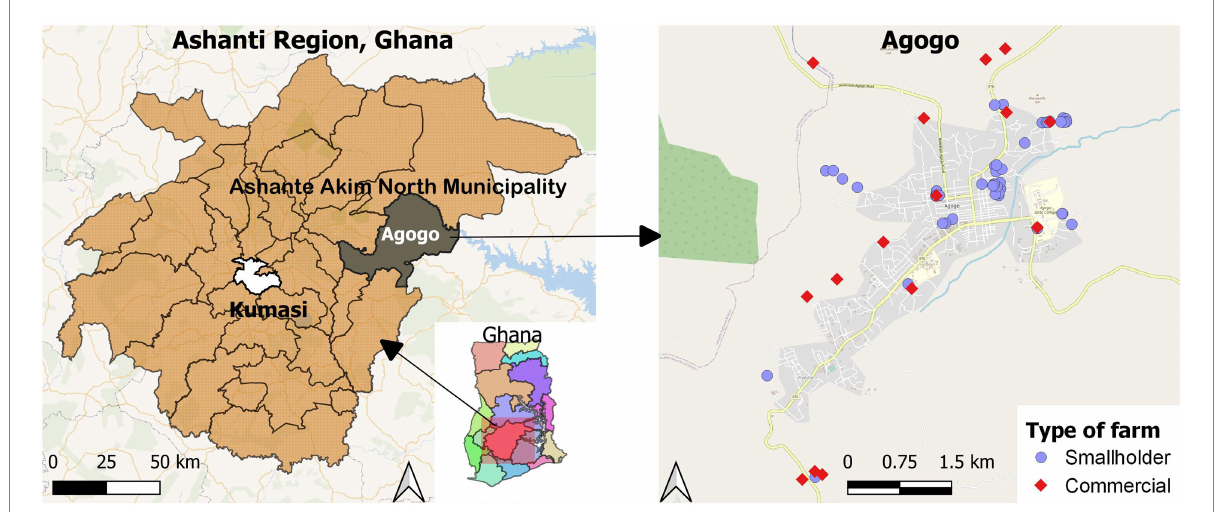
FIGURE 1 Location of commercial and smallholder farms in Agogo in the Ashanti region, Ghana.